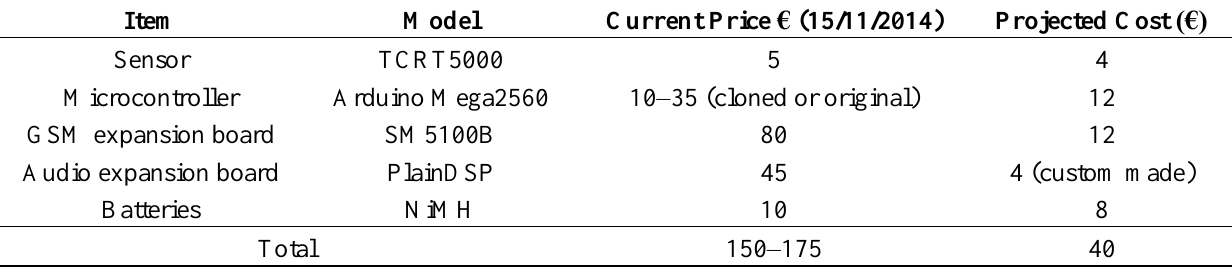
Table 1. Cost breakdown of the hardware of the electronic McPhail trap. Projected cost refers to custom-made